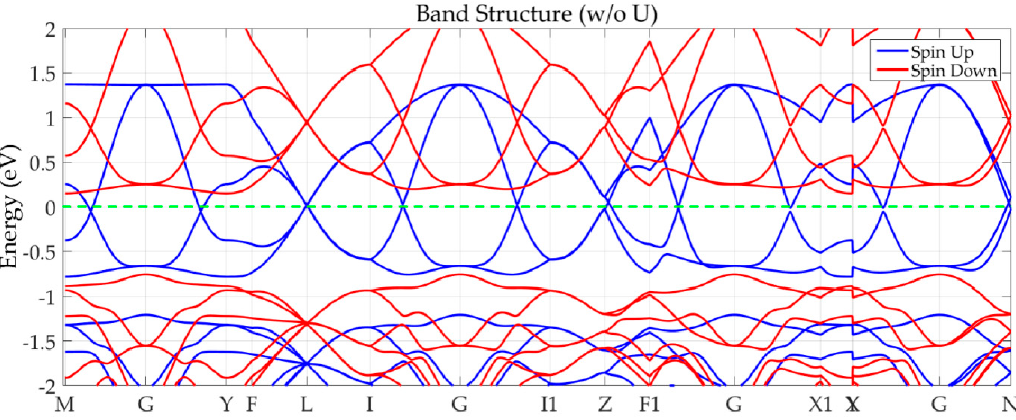
Figure 1. Band structure of bulk PdF 3 calculated based on the Perdew − Burke − Ernzerhof function without consideration to the spin-orbit coupling effect.